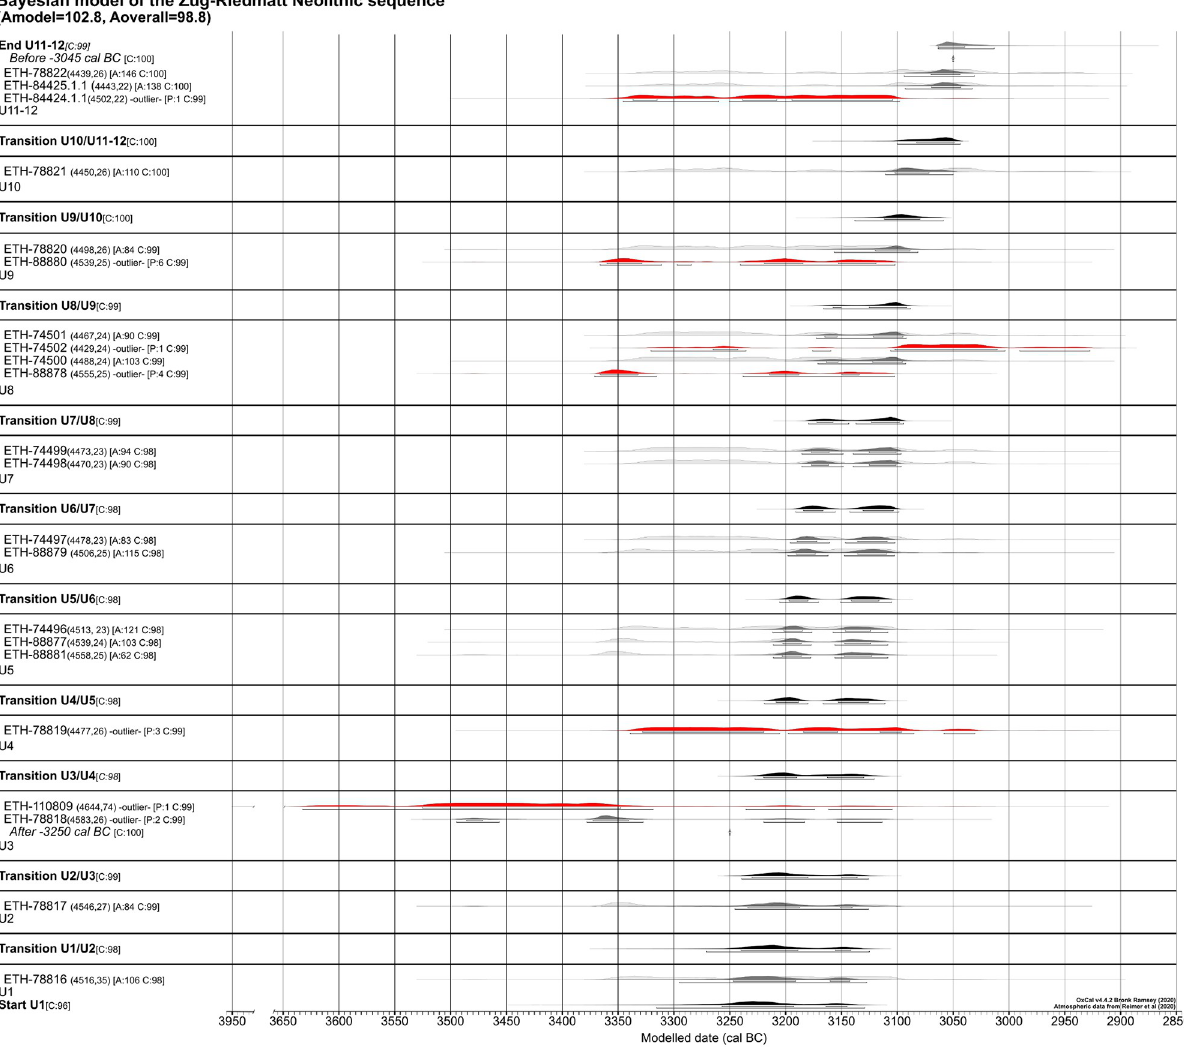
Fig 18. Bayesian model of the datings of the stratigraphical units of Zug-Riedmatt.